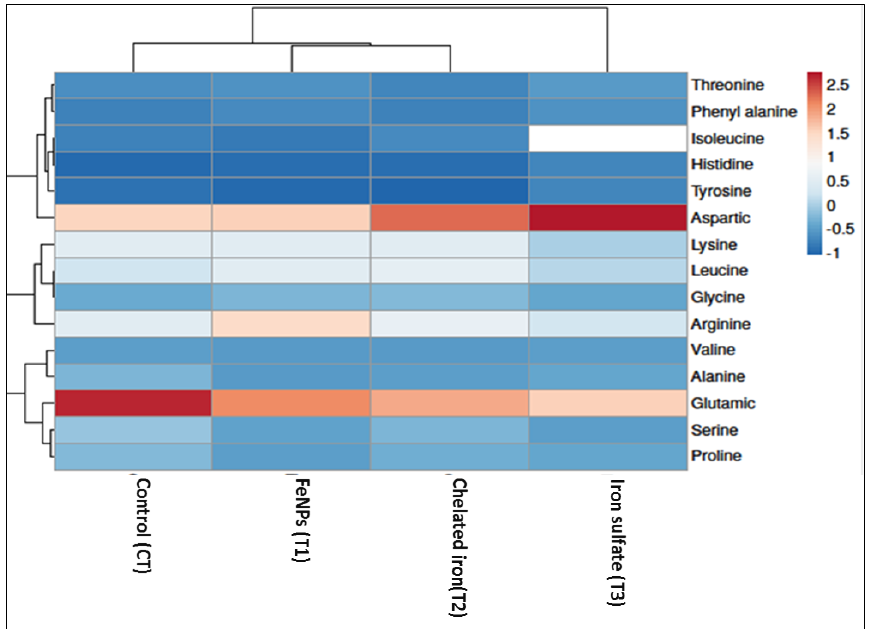
Figure 6. Correlation heat map between different amino acids in seeds of Vicia faba and different iron sources. Positive relationships are presented in red color and negative relationships in blue color. T1 = Synthesized nano-iron, T2 = Chelated iron, T3 = Iron sulfate, and CT = Control.